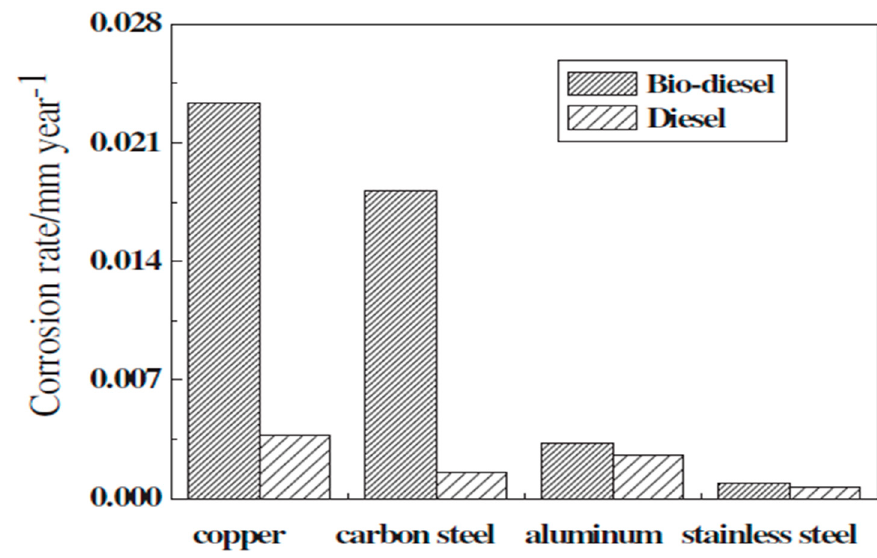
Figure 7. CRs of metals in diesel and biodiesel [71].